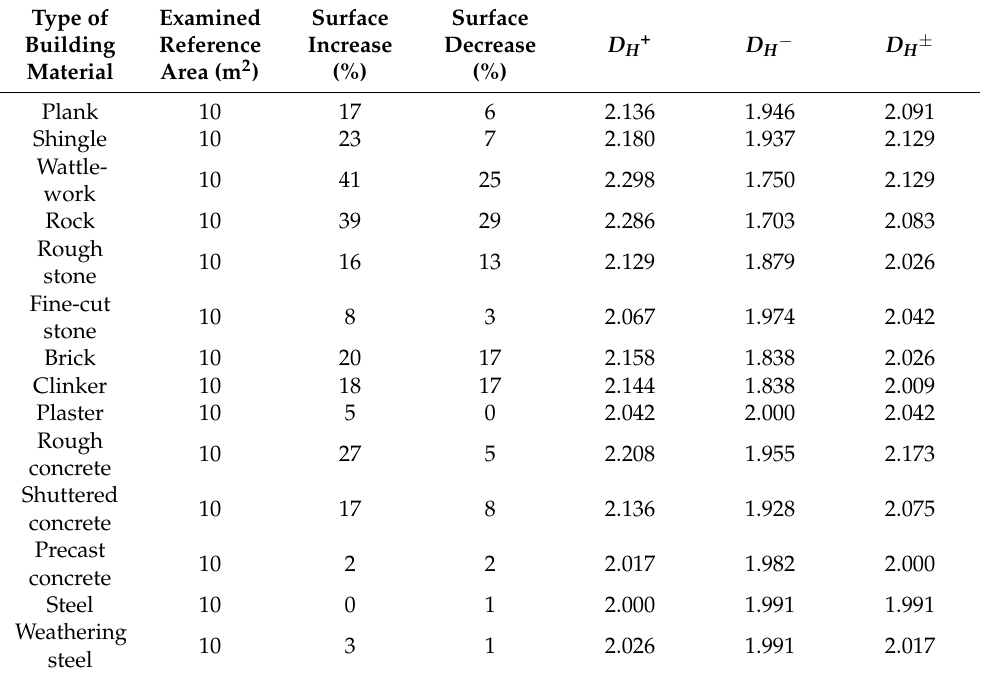
Table 1. The Hausdorff dimensions of walls or claddings built from some well-known materials. Surface measurements were made through the use of digital photography, image processing and metric data provided by manufacturers.